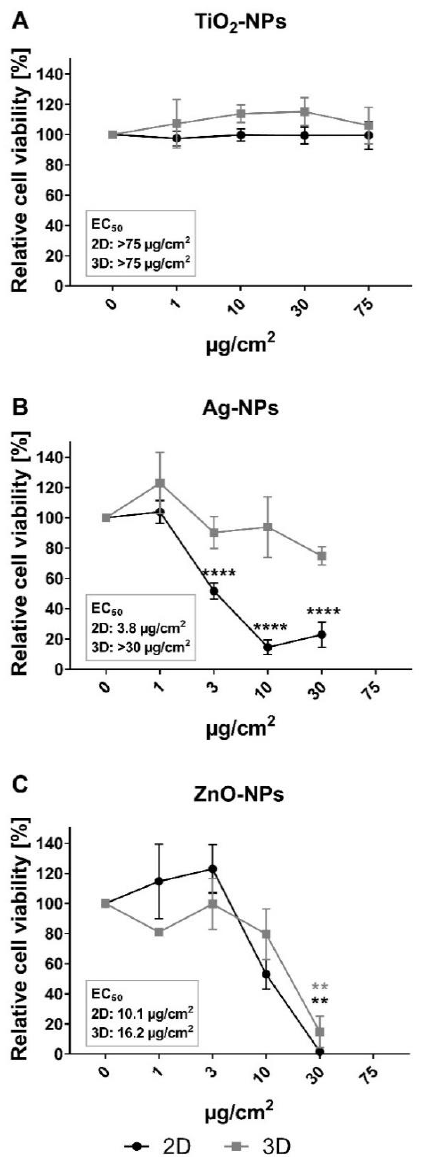
Figure 3. Cytotoxicity of TiO 2 -, Ag- and ZnO-NPs measured by alamarBlue assay in 2D and 3D HepG2 cultures. Cell viability was measured as metabolic capacity and calculated relative to negative control cultures (set to 100%). ( A ) No significant e ff ects were seen on the viability of 2D (black curve) and 3D (gray curve) cultures after 24 h exposure to TiO 2 -NPs. The cell viability was reduced after 24 h incubation with ( B ) Ag-NP and ( C ) ZnO-NP for both 2D and 3D cultures. The e ff ect of the exposure was significantly di ff erent in 2D and 3D cultures after exposure to Ag-NP at concentrations 10 and 30 µ g / cm 2 , evaluated by two-way ANOVA with post-test Sidak. Values are presented as mean ± SEM of 2–6 independent experiments: ( A ) n = 2, 3, ( B ) n = 4–6 and ( C ) n = 3. The concentration 75 µ g / cm 2 was excluded for testing of Ag-NP and ZnO-NP (b and c) because of high cytotoxicity in previously published experiments [36]. ** p < 0.01; **** p <